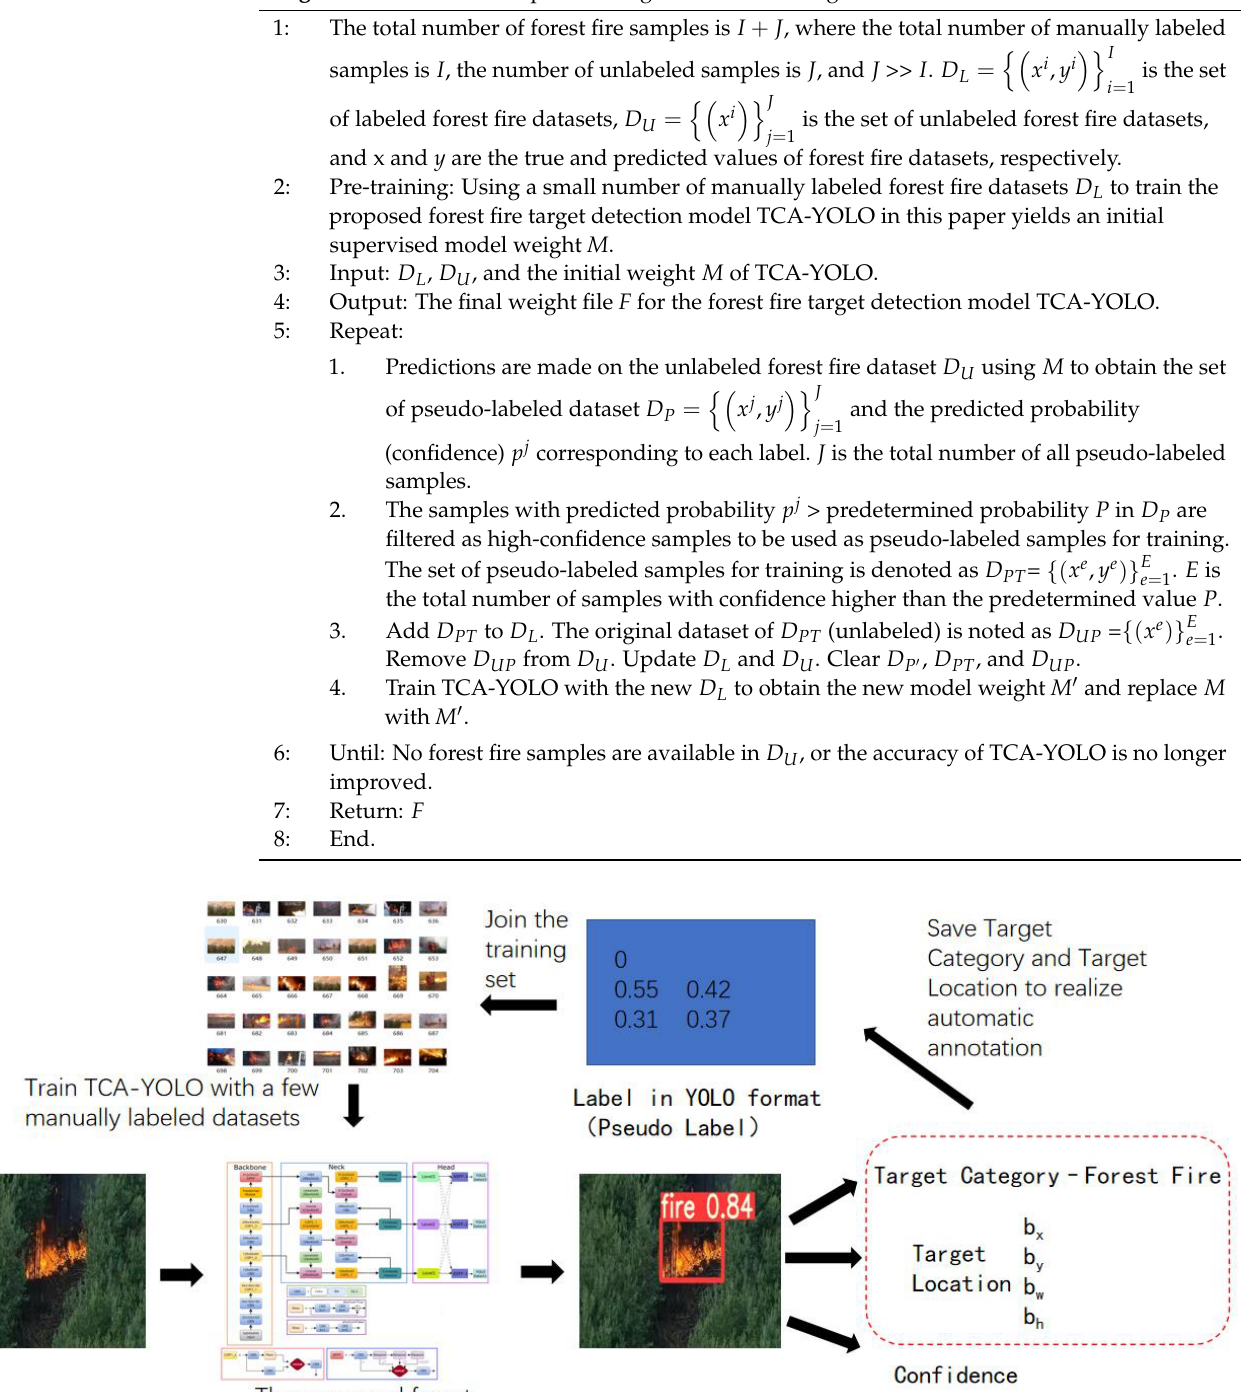
Algorithm 1: The semi-supervised algorithm for training TCA-YOLO